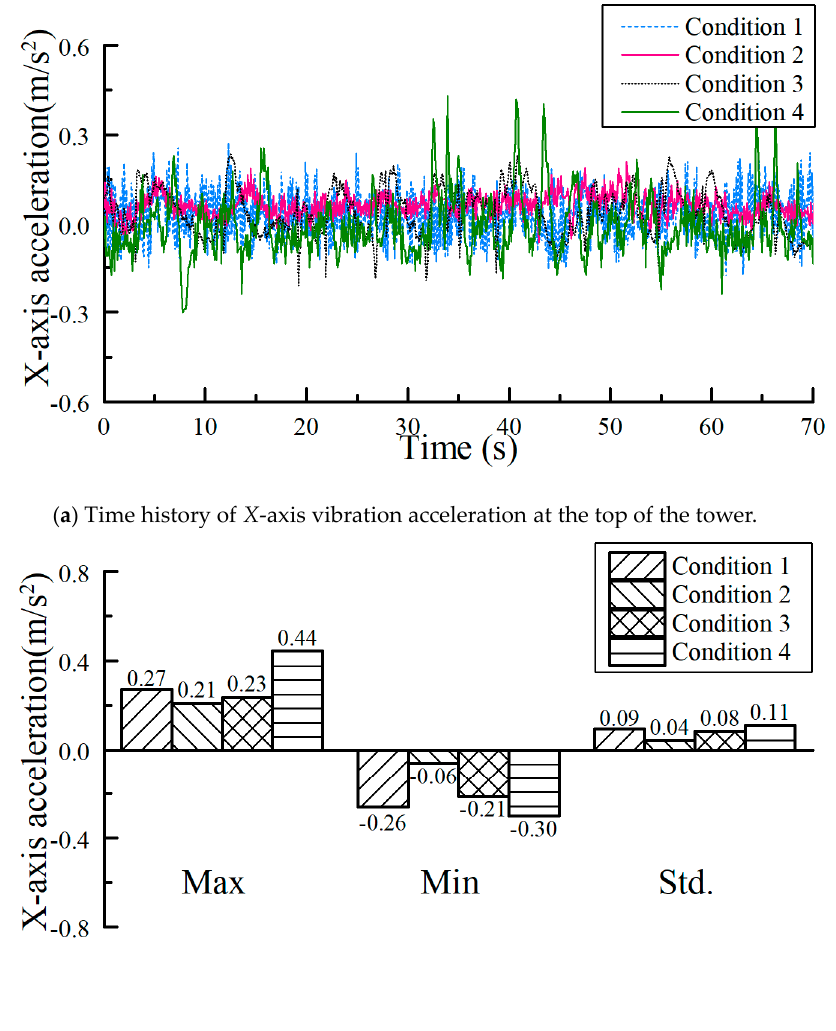
Figure 15. X -axis vibration acceleration at the top of the tower.